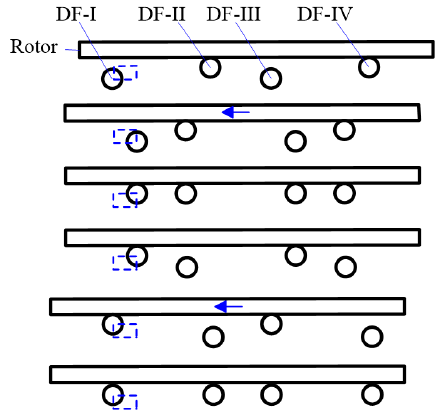
Figure 2. Illustration of the four-feet walking mechanism (expansion view along circumferential direction).